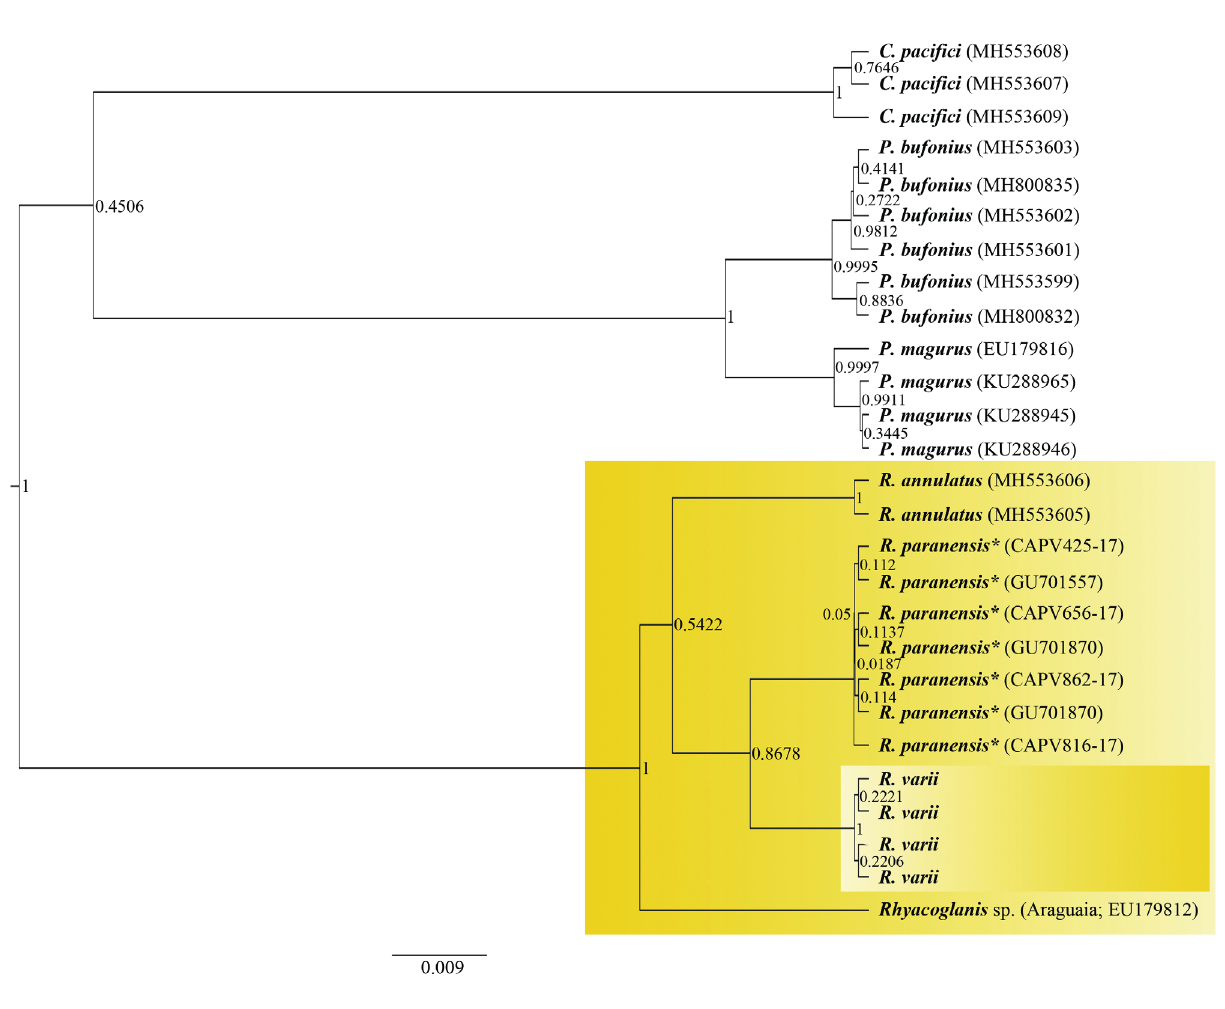
FIGURE 10 | Pseudopimelodidae species delimitation with Bayesian GMYC analysis. The cluster of supported species is indicated in red, and the Rhyacoglanis cluster is highlighted in yellow ocher. The numbers on the nodes represent the posterior probability, and the branch length represents the time in My. Genbank accession number in parenthesis; * = specimens identified as Pseudopimelodus mangurus in Genbank.